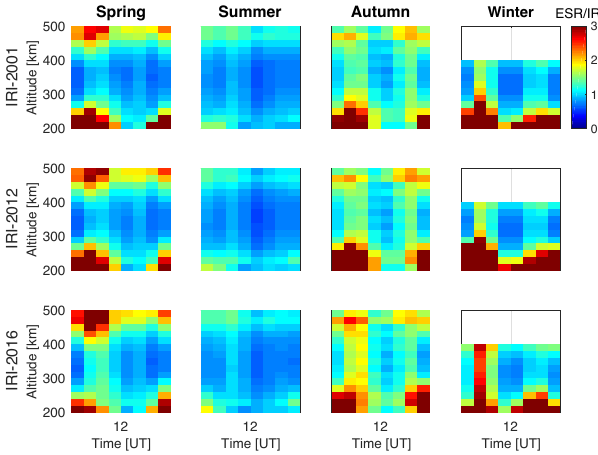
Figure 4. Altitude profiles of the ratio between ESR and IRI elec- tron densities for three different versions of the IRI model (IRI- 2001, IRI-2012 and IRI-2016) in 2001. The data have been binned according to season, as indicated, and as daily 3h averages. The rows show how the IRI-2001, IRI-2012 and IRI-2016 models re- produce the polar ionosphere during 2001 respectively.